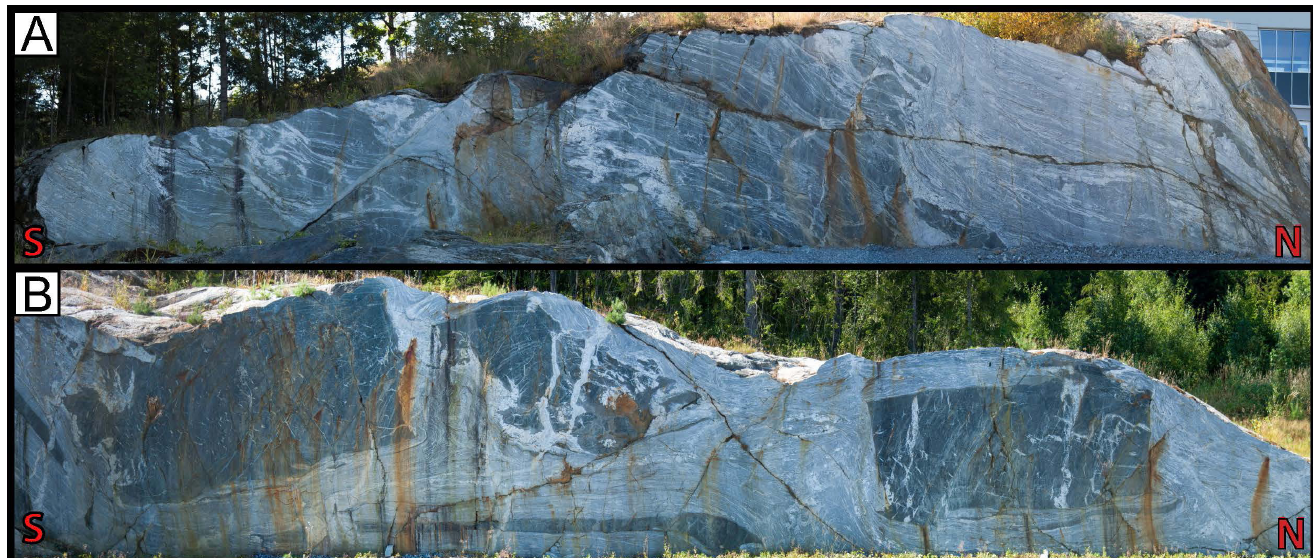
Figure 2. Overview of selected parts of shear zone at the Halden locality. (A) Segment A and in Fig. 3. (B) Northernmost part of segment C in Fig. 3. The important features, sample labels and other details are highlighted in the map of Fig.